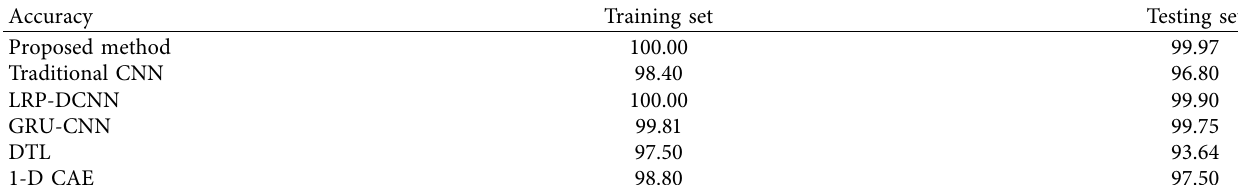
Table 6: The accuracy comparison between the proposed method in this paper and the other methods.